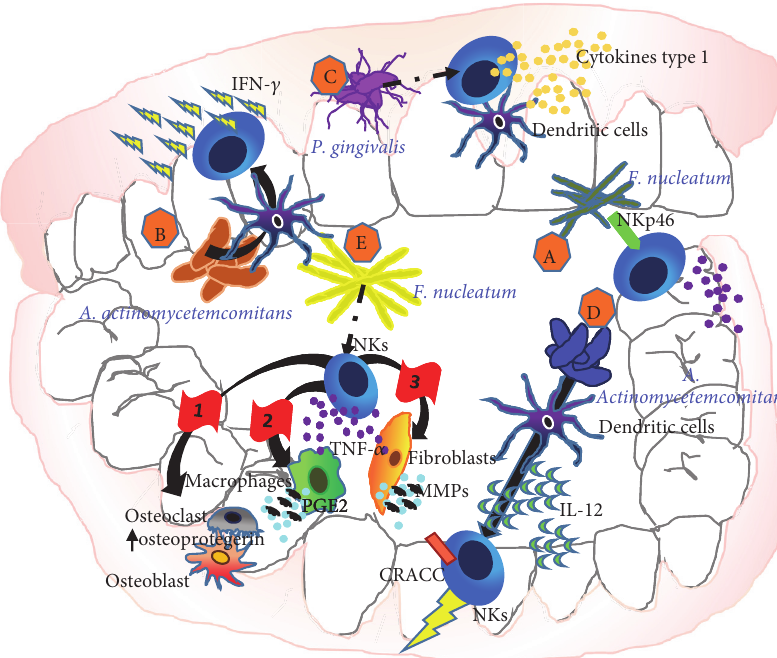
Figure 4: Interaction between NK cells and the main bacterial species involved in the pathogenesis of periodontitis. Direct recognition of Fusobacterium nucleatum through NKp46 worsts periodontal disease (A). Actinobacillus actinomycetemcomitans stimulate dendritic cells that in turn elicit rapid gamma interferon responses by natural killer cells (B). P. gingivalis induces a rapidly increase of type 1 cytokine production by both dendritic cells and NK cells (C). Aggregatibacter actinomycetemcomitans i nduces CD2-like receptor activating cytotoxic cells (CRACC) on NK cells, via activation of dendritic cells and subsequent interleukin 12 (IL-12) signalling that results in an aggressive (D). NK cell following F. nucleatum recognition can release TNF- 𝛼 that on one hand leads to tissue damage by stimulating prostaglandin E2 release from monocytes and fibroblasts and secretion of metalloproteinases that degrade extracellular matrix (ECM) proteins and on the other hand induces osteoclast differentiation and activation by increasing RANKL expression and the suppression of osteoprotegerin, a cytokine receptor that belongs to tumour necrosis factor (TNF) receptor superfamily expression in osteoblasts, resulting in alveolar bone resorption